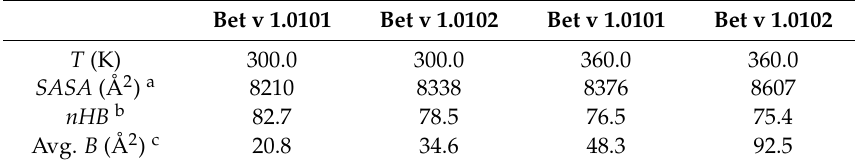
Figure 2. Molecular dynamics simulations of nanosecond-microsecond conformational flexibility in Bet v 1 isoforms. ( a ) Site-specific B -factors of Bet v 1.0101 ( blue ) and Bet v 1.0102 ( red ) derived from structural ensembles of microsecond molecular dynamics (MD) simulations at 300 K. Flexibility on the nanosecond-microsecond time scale leads to elevated B -factors. Secondary structure elements are indicated on top. Amino acid positions that are different in Bet v 1.0101 and Bet v 1.0102 are indicated by asterisks (*) and the early proteolytic cleavage sites I – IV are shown in green. ( b ) Comparison of average B -factors of Bet v 1.0101 ( blue ) and Bet v 1.0102 ( red ) at MD simulation temperatures of 300 and 360 K, respectively. Table 1. Molecular dynamics simulations of nanosecond-microsecond flexibility in Bet v 1 isoforms. Comparison of structural and dynamical descriptors extracted from the conformational ensembles in 300 and 360 K MD